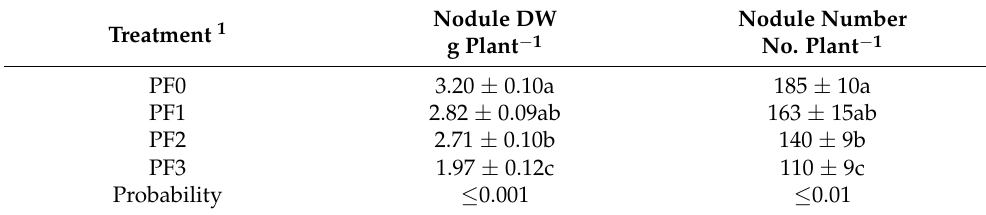
Table 4. Nodule dry weight (DW) and number of S. sesban as affected by pruning frequency.